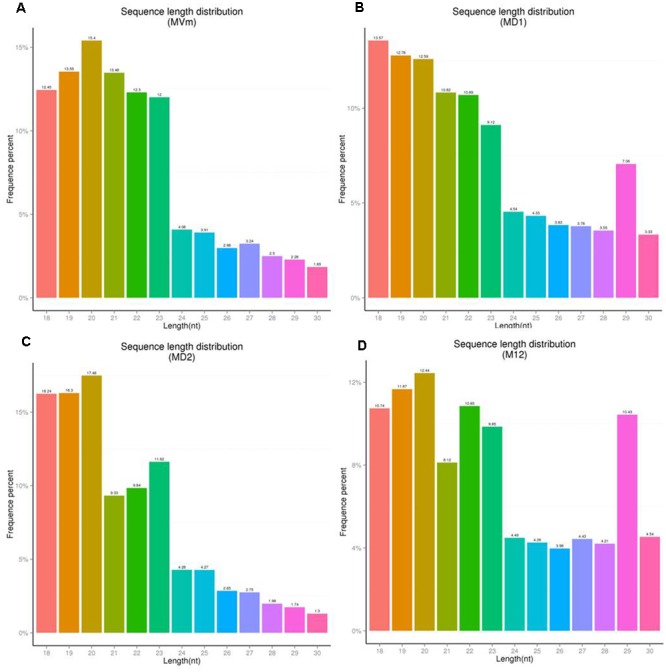
Sequence length distribution of unisRNAs in the VmDCL mutants and 03–8. The length distribution of the unisRNAs changed when VmDCL1
(B), ΔVmDCL2
(C) and ΔVmDCL1DCL2
(D) were deleted compared with 03–8 (A). Horizontal axis indicates the sequence length, the vertical axis indicates the proportion of the corresponding reads, and the colors indicate the different lengths. MVm, 03–8; MD1, ΔVmDCL1; MD2, ΔVmDCL2; MD12, ΔVmDCL1DCL2.